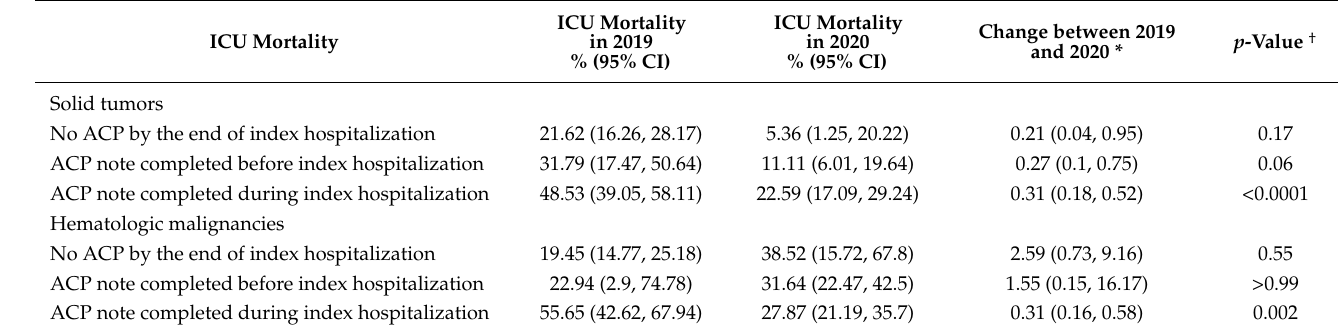
Table 4. ICU mortality rate by ACP completion status and tumor type.